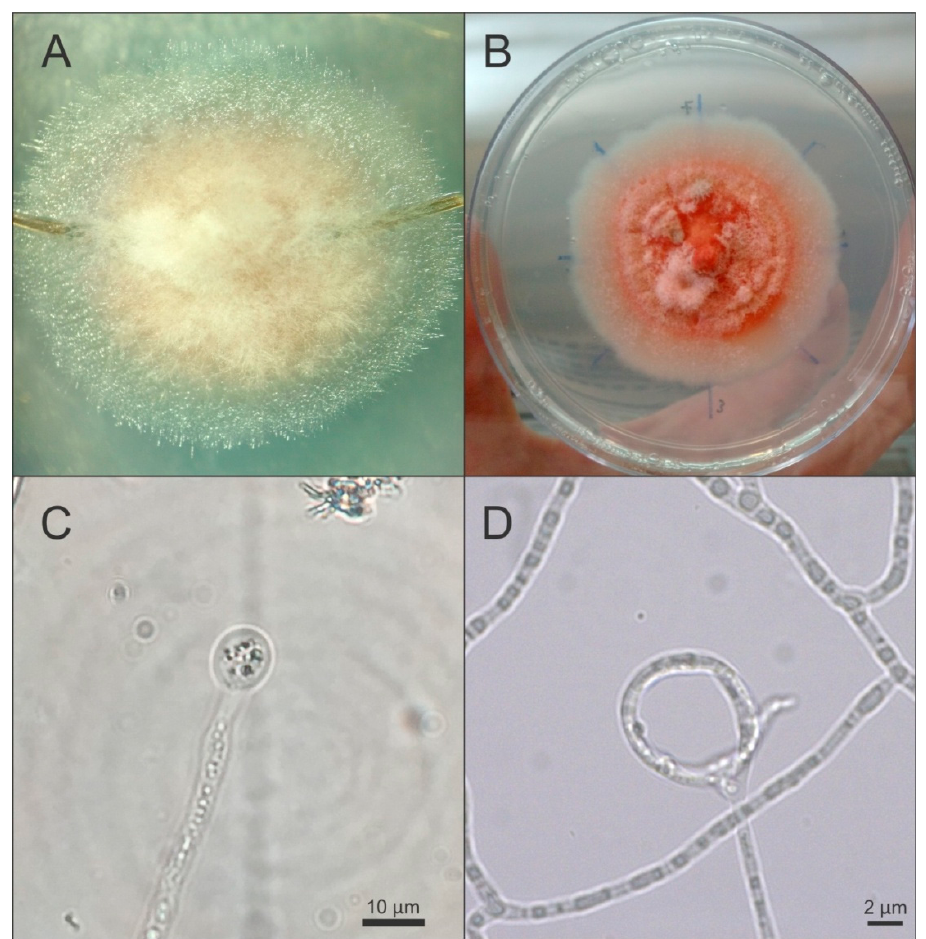
Figure 4. Juncaceiola cf. typharum . ( A ) Isolation of the fungus through a fragment of D. antarctica . ( B ) Isolated culture of Juncaceiola cf. typharum . ( C ) Chlamydospore. ( D ) Nematode ring. Scale bars: C = 10 µm, D = 2 µm.